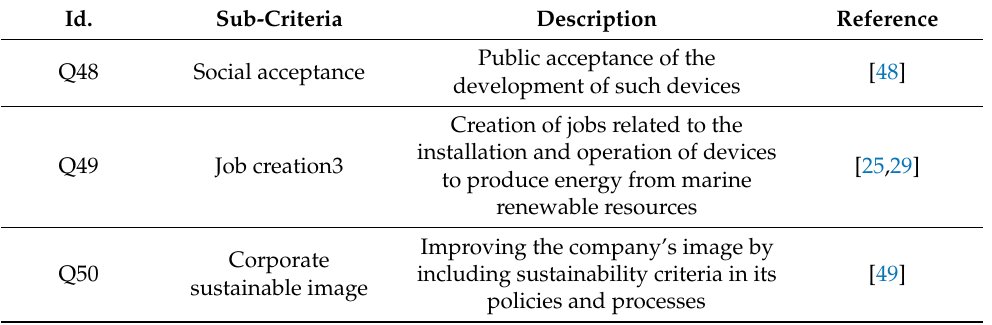
Table A11. Block 10: Influence of social factors. Q48 to